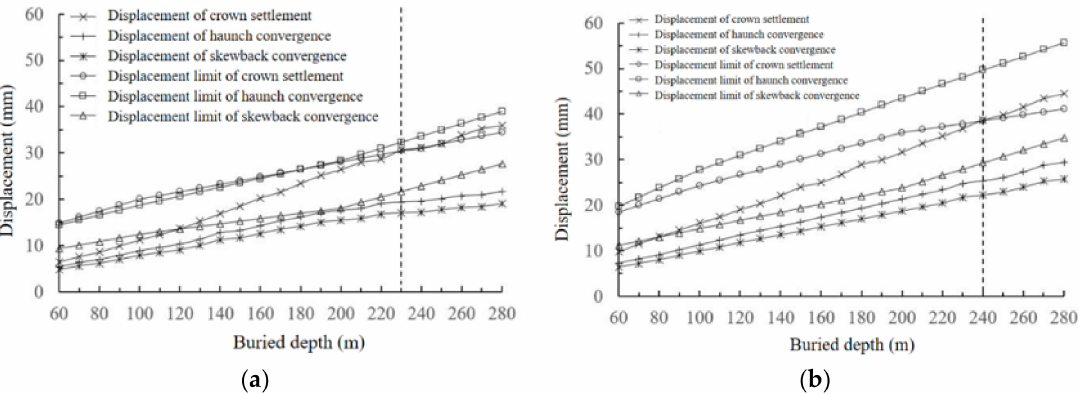
Figure 5. Relationship between the simulated and displacement limits and the buried depth under different surrounding rock grades. ( a ) Grade IV surrounding rock; ( b ) Grade V surrounding